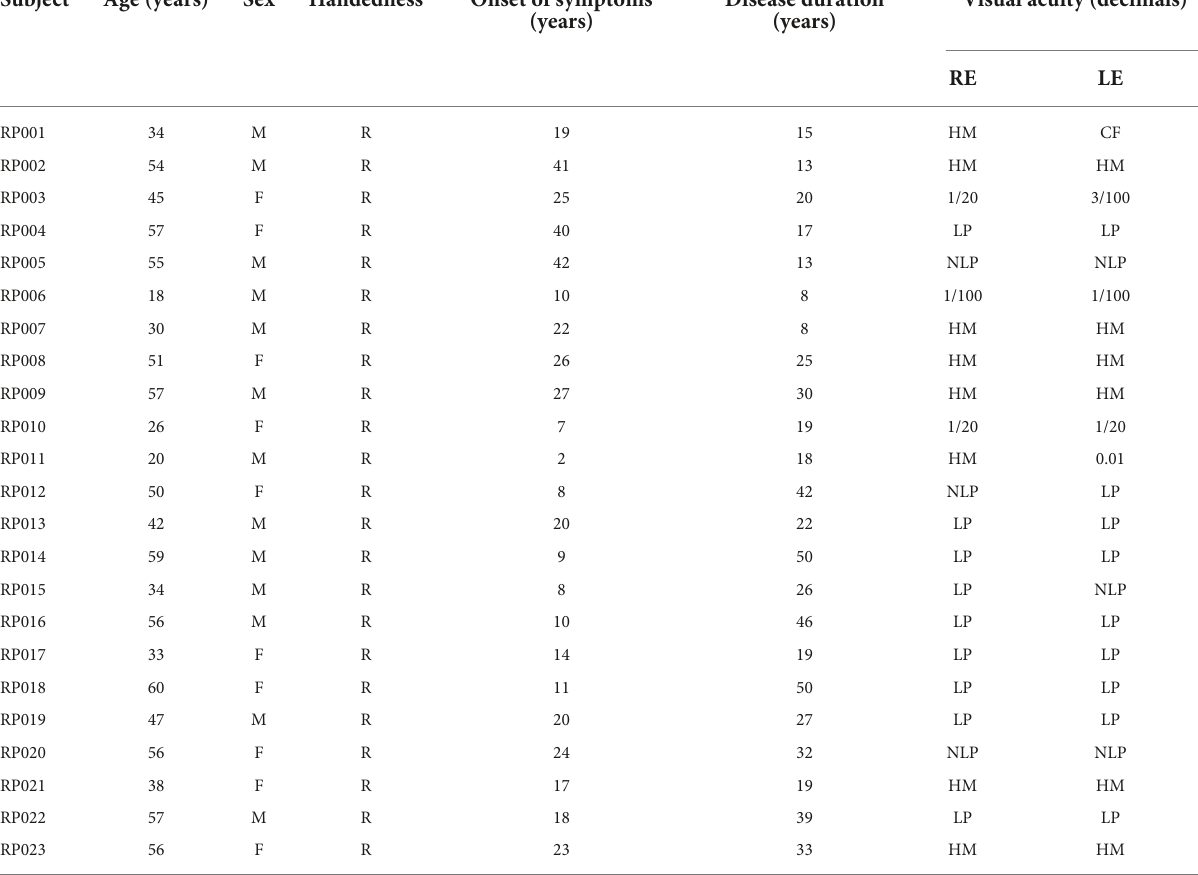
TABLE 1 Detailed clinical characteristics of patients with